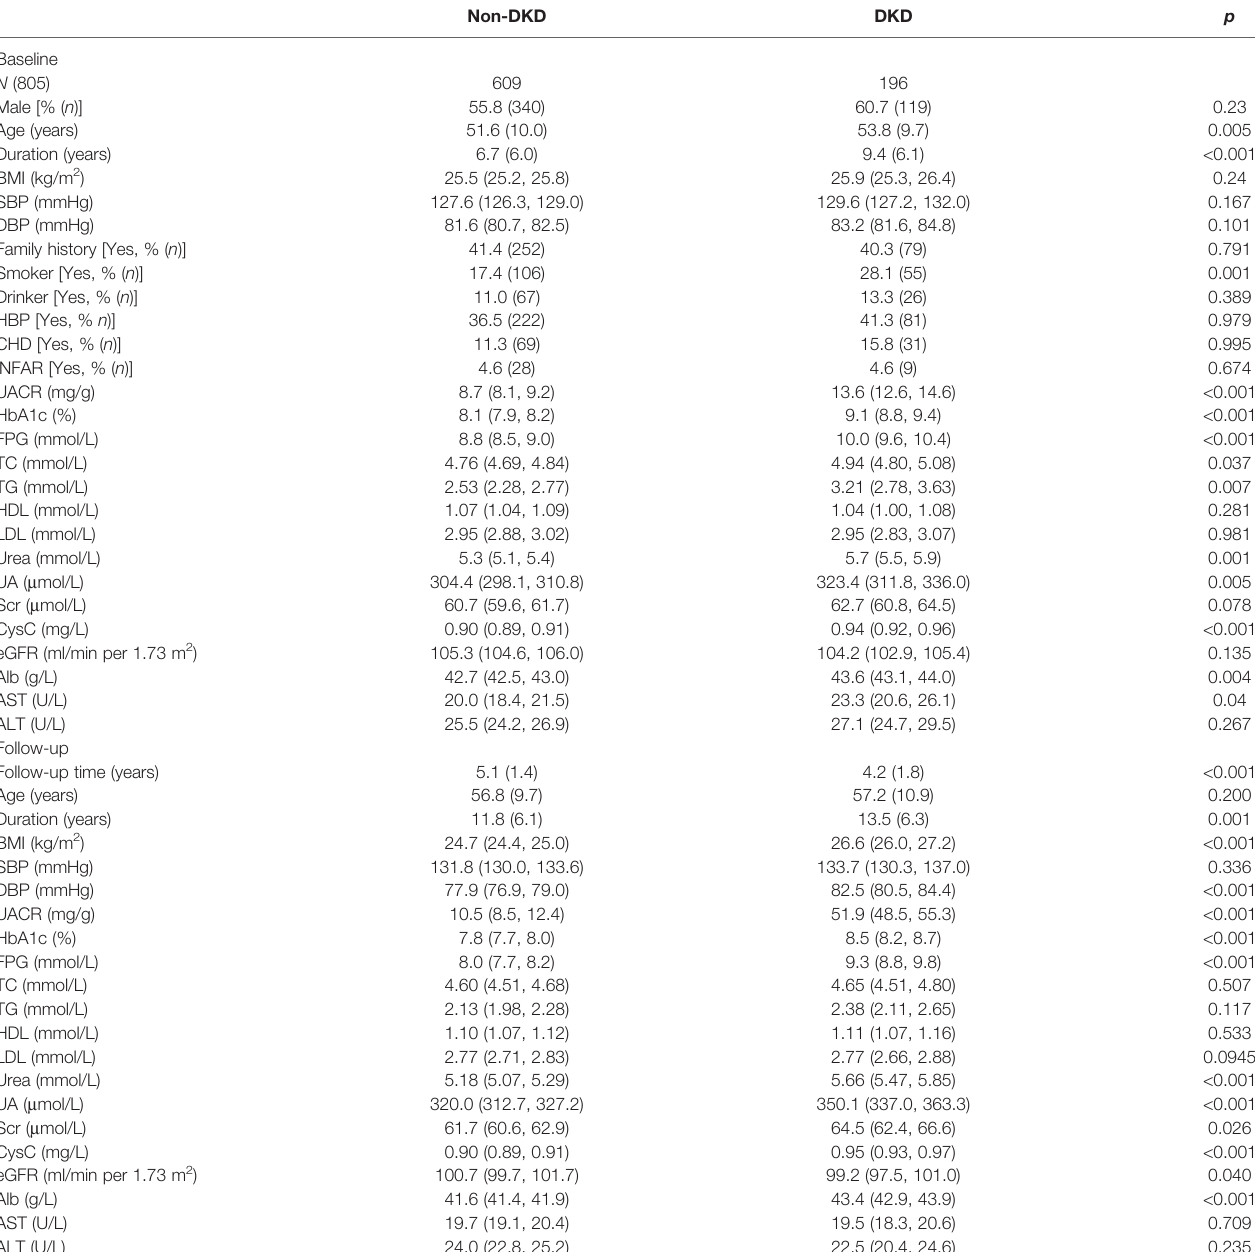
TABLE 1 | Baseline and follow-up characteristics by incidence of DKD. Non-DKD